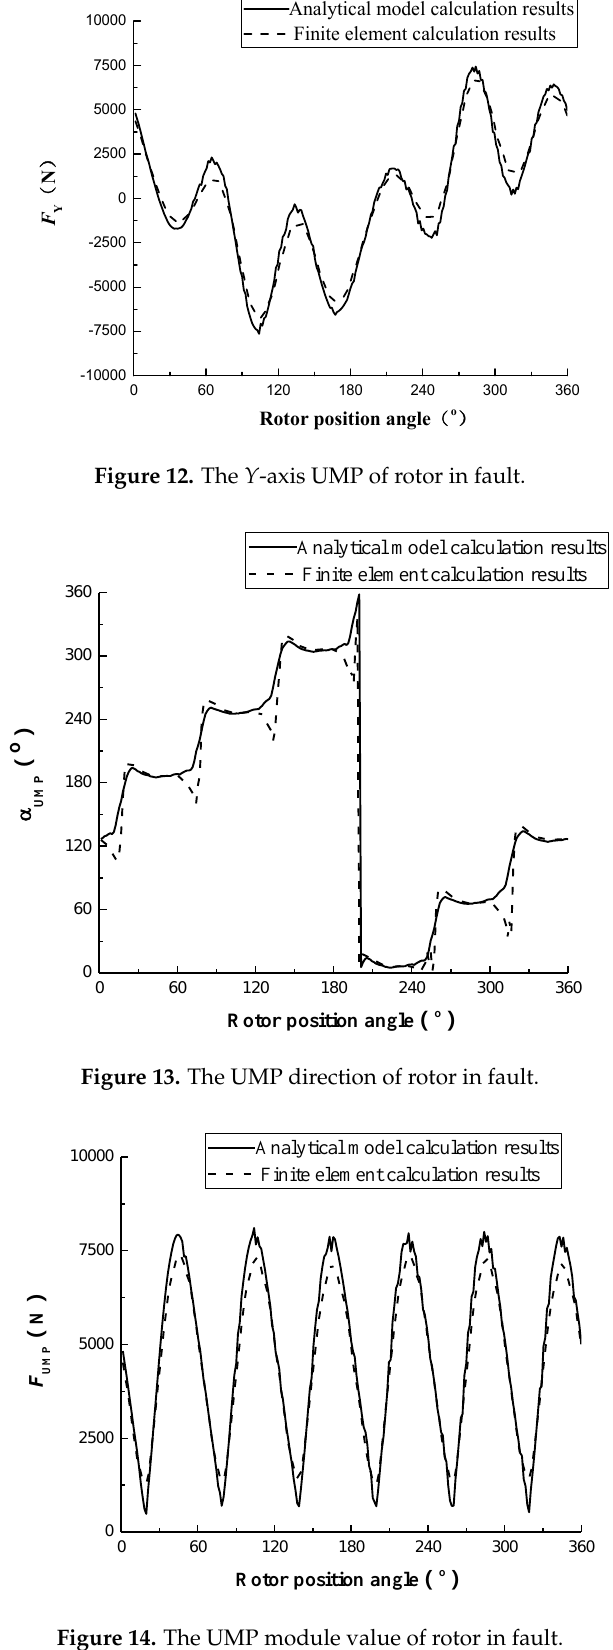
Figure 14. The UMP module value of rotor in fault.